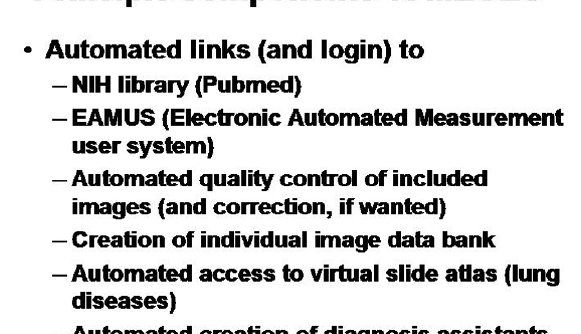
Figure 9 Principle components of MECES